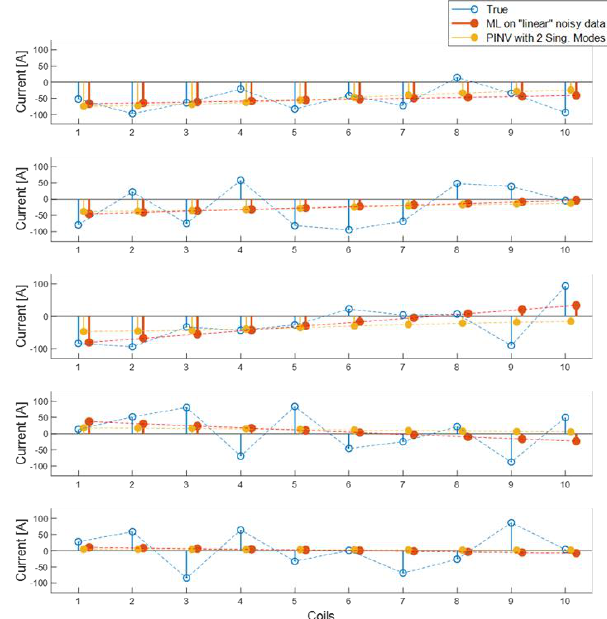
Figure 9. Five examples of reconstructed currents in the validation data set, using only linear current distribution to create a regression model. Blue: true currents; red: reconstructions using RRA with linear noisy data; and yellow: reconstructions using pseudo-inverse with two singular modes kept. Dashed lines connecting the values highlight the trend of the currents with respect to the conductor index.